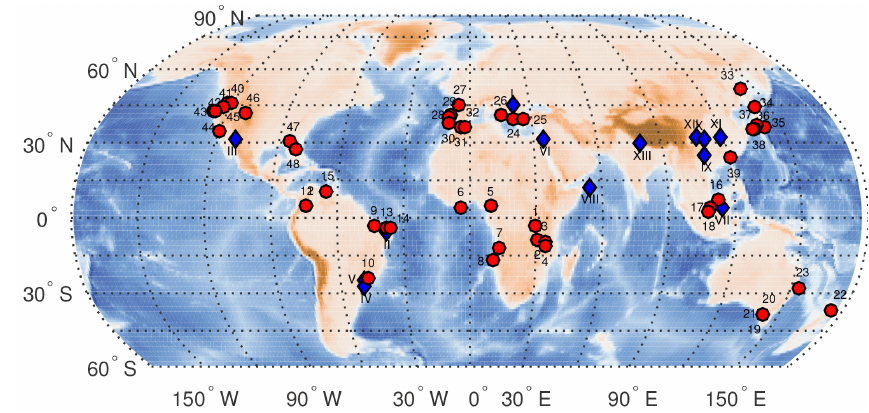
Figure 7. Location of marine and terrestrial paleoarchives sites included in the model–data comparison. Blue diamonds denote speleothem’s calcite δ 18 O and red circles denote pollen records. Arabic numbers and Roman numerals displayed on the map identify the location of the paleoarchives listed in Tables 3 (hydrology) and 4 (vegetation) for site names, references and further